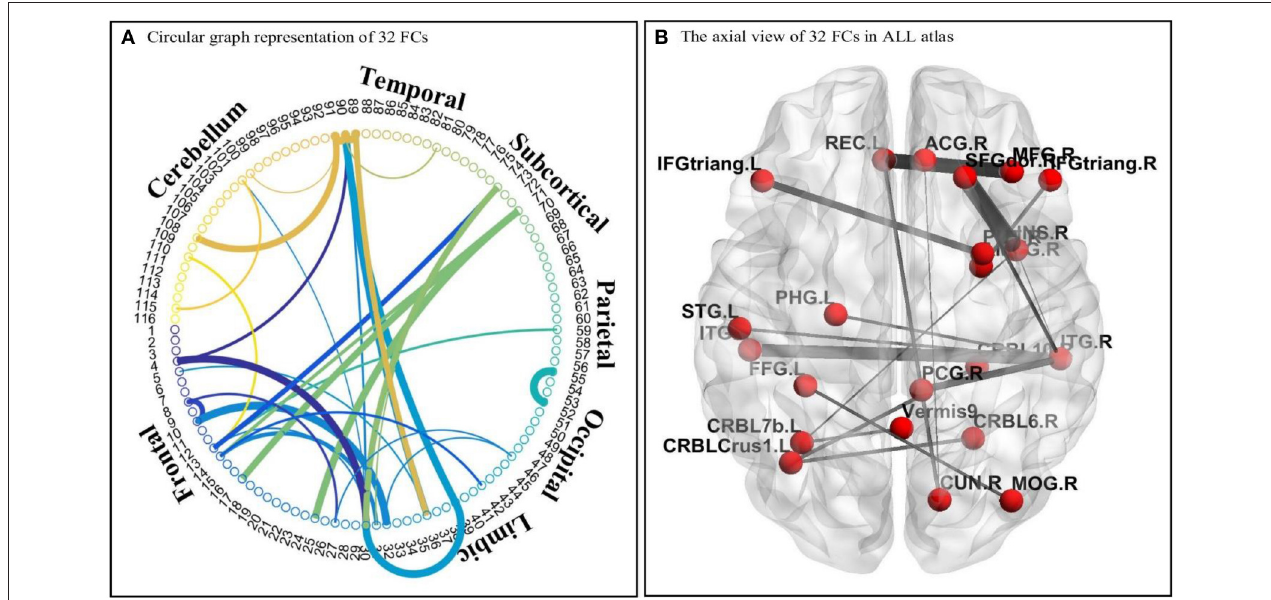
FIGURE 10 | The visualization of 32 identified FC elements. (A) The circular visualization. Thicker connections indicate regions are strongly correlated, and vice versa. “circularGraph” toolbox (www.mathworks.com/matlabcentral) was applied to draw the figure. (B) The axial visualization in AAL atlas. Labels information was from AAL atlas. The thicker connection indicates two regions are strongly correlated, and vice versa. The BrainNet Viewer software (www.nitrc.org/projects/bnv) was applied to draw the figure.